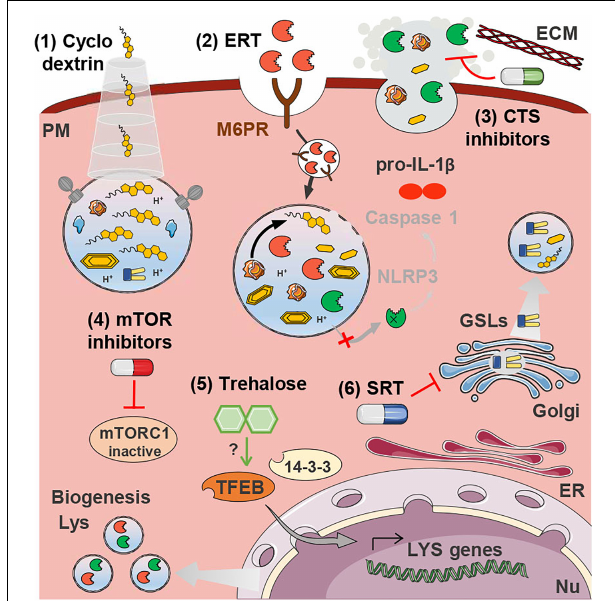
FIGURE 2 | Therapeutics for atherosclerosis targeting lysosomal dysfunction. Cyclodextrin (1) releases the FC sequestered inside lysosomes. ERT (2) is based on the delivery of recombinant LAL that is taken up by mannose-6-phosphate receptors (M6PR) and directed to the lysosomes. In the acidic lumen of lysosomes LAL is released from the M6PR and catalyzes the hydrolysis of accumulated CE. Cathepsin (CTS) inhibitors (3) may be beneficial to plaque stability by preventing the degradation of the ECM, and by decreasing the aggregation of LDL, which hampers its uptake by non-regulated SRs. Both mTOR inhibitors (4) and trehalose (5) drive lysosome biogenesis by stimulating the translocation of TFEB to the nucleus where it drives the transcription of lysosomal genes. SRT (6) is based on the inhibition of the (glucosylceramide) synthase responsible for the production of glycosphingolipids (GSLs) that would otherwise accumulate inside lysosomes. All these strategies, with the exception of (3), have the potential to decrease the accumulation of lysosomal substrates and thereby restore membrane integrity, preventing cathepsin release and NRLP3 inflammasome activation (IL-1 β production and release). This has only been experimentally demonstrated in the case of trehalose treatment. Some images in this figure were adapted with permission from Servier Medical Art, licensed under a Creative Common Attribution 3.0 Generic License